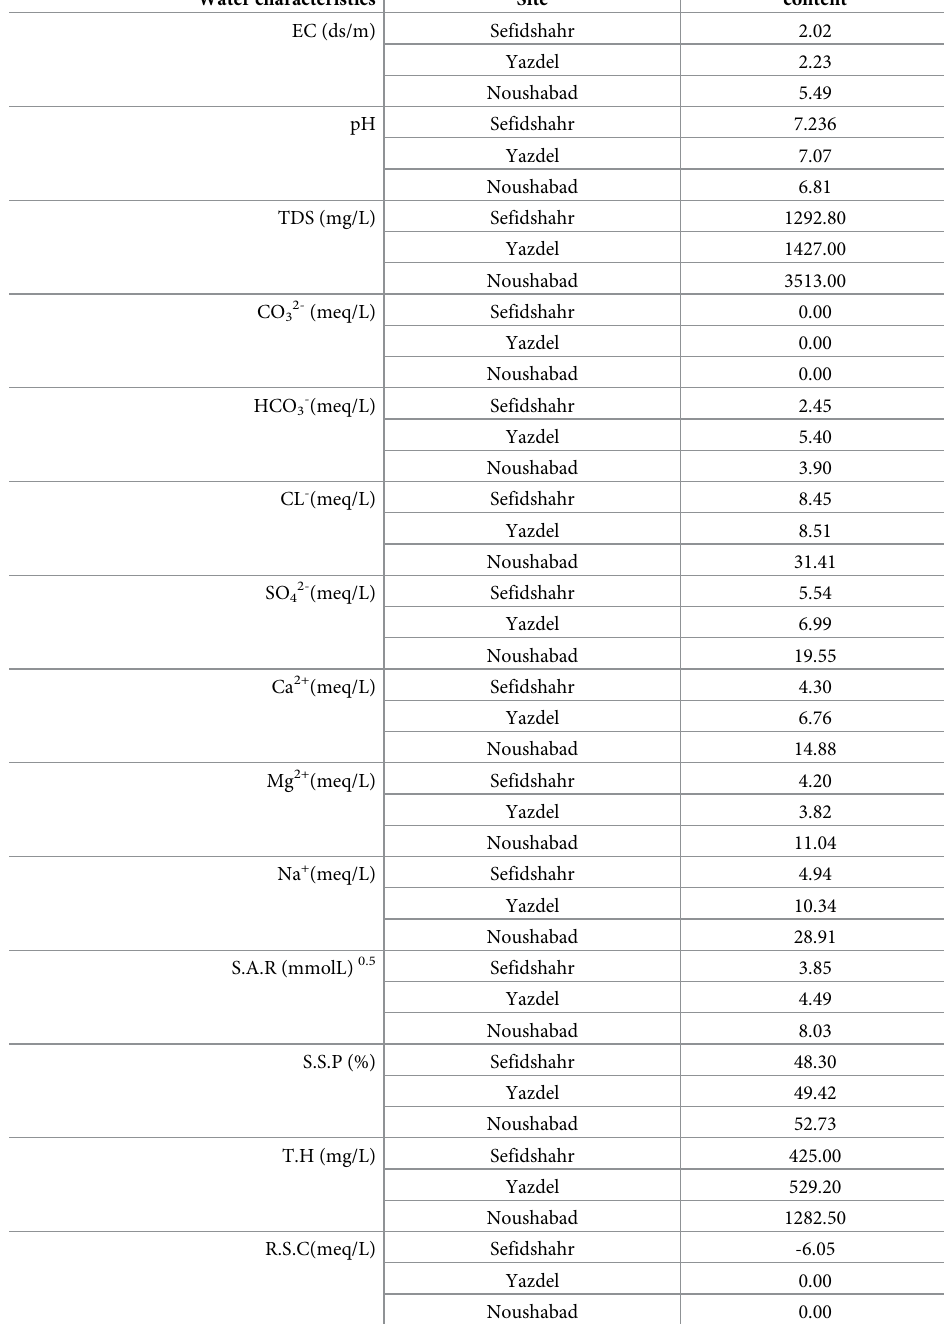
Table 2. Irrigation water characteristics at the studied crop